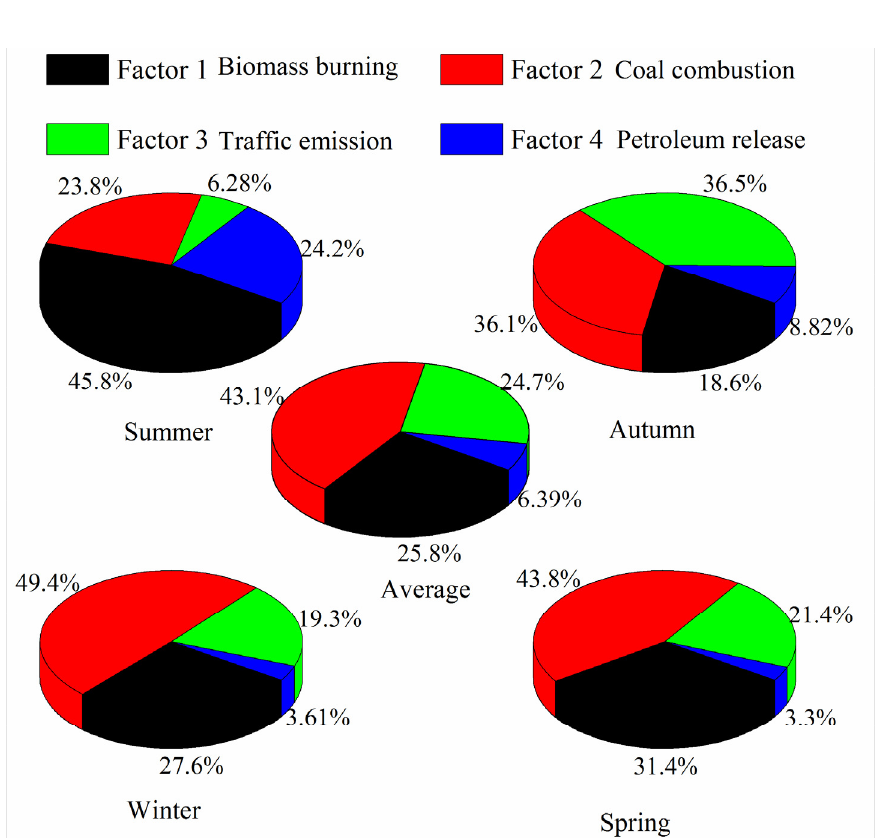
Figure 4. Seasonal contributions of four source factors to PAHs in PM 2.5 identified by the PMF modeling.